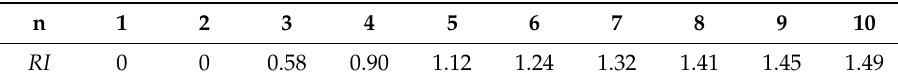
Table 3. The random consistency index